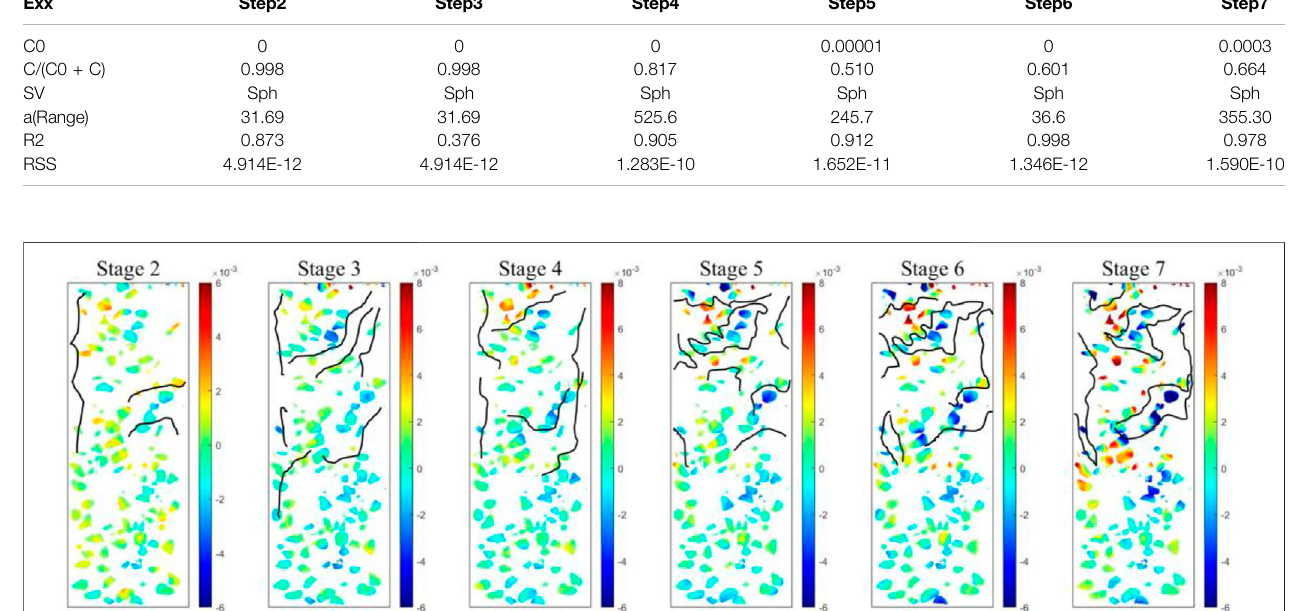
FIGURE6| Shearstraininrock blockunderdifferentstressstrengths;shearbandsarerepresentedbyblack lines. (A) istheStage 2,and (B – F) aretheStage3 – 7, respectively.